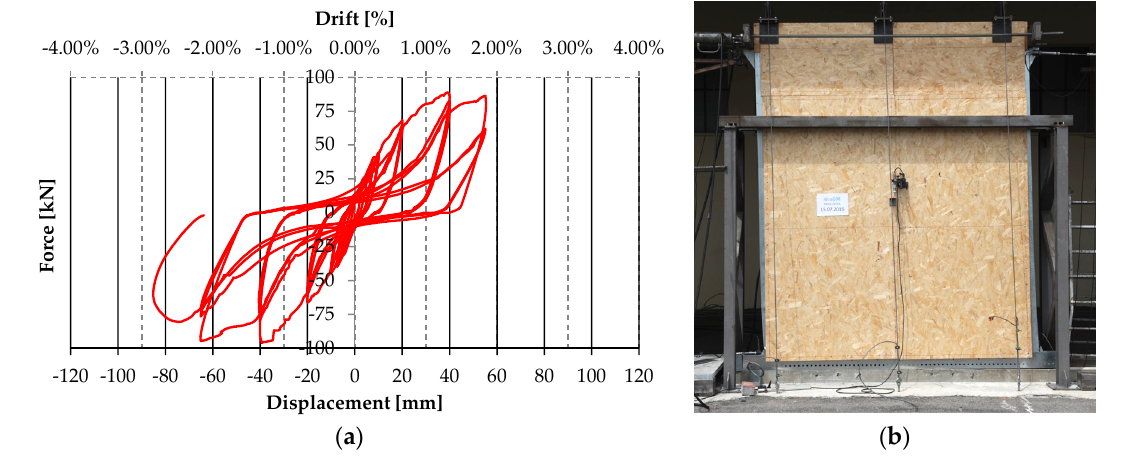
Figure 8. ( a ) Force vs. top displacement curve; ( b ) deformed specimen at 60 mm cycles.